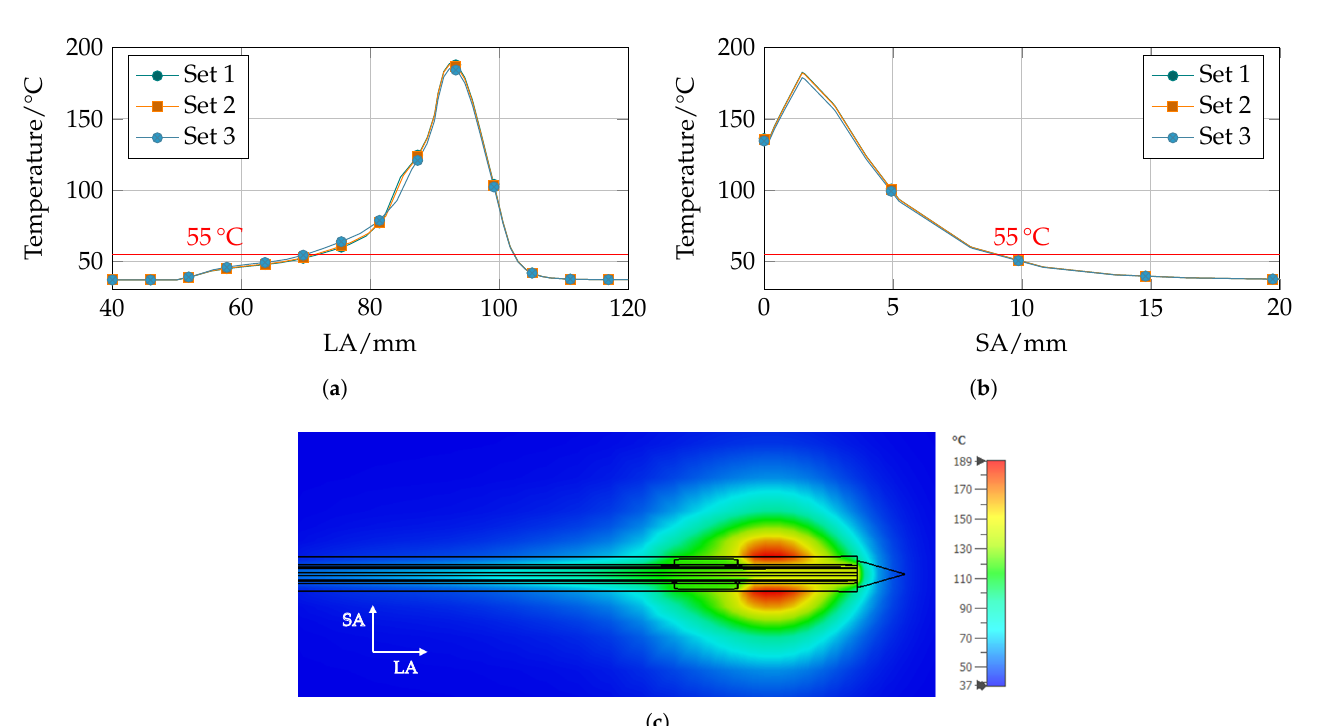
Figure 6. Thermal simulation result of Pareto-optimal parameter sets. Temperature along the ( a ) axial (LA) and ( b ) radial (SA) direction for all three sets and ( c ) the thermal ablation zone from three-dimensional simulations of parameter set